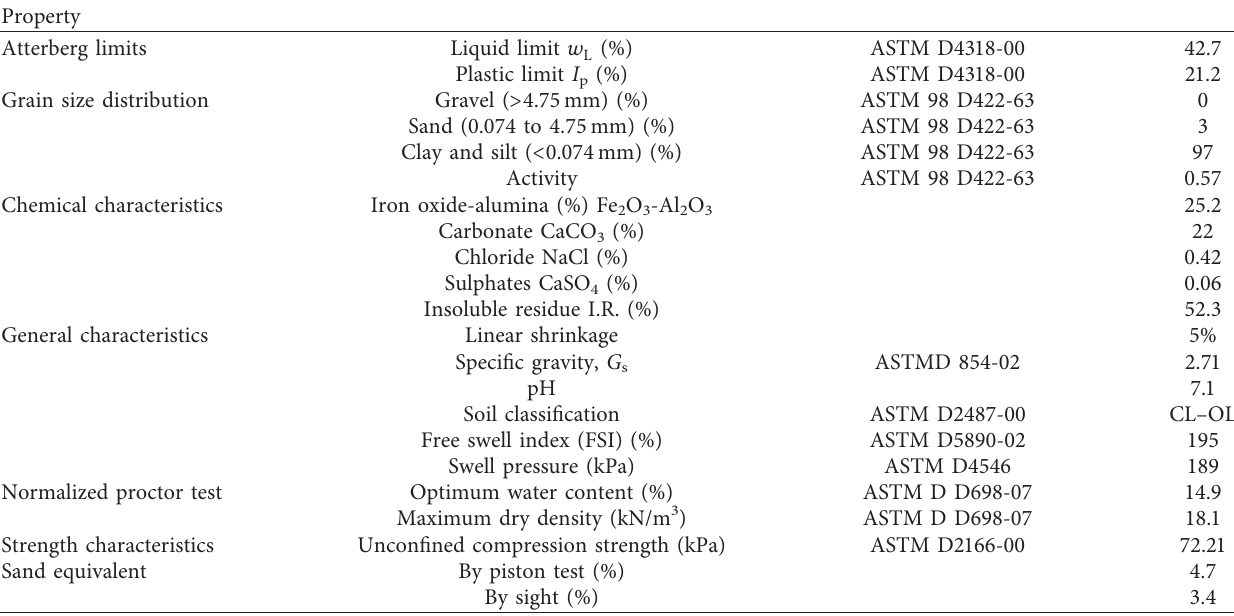
Table 1 into the following steps: a series of Atterberg limits test,